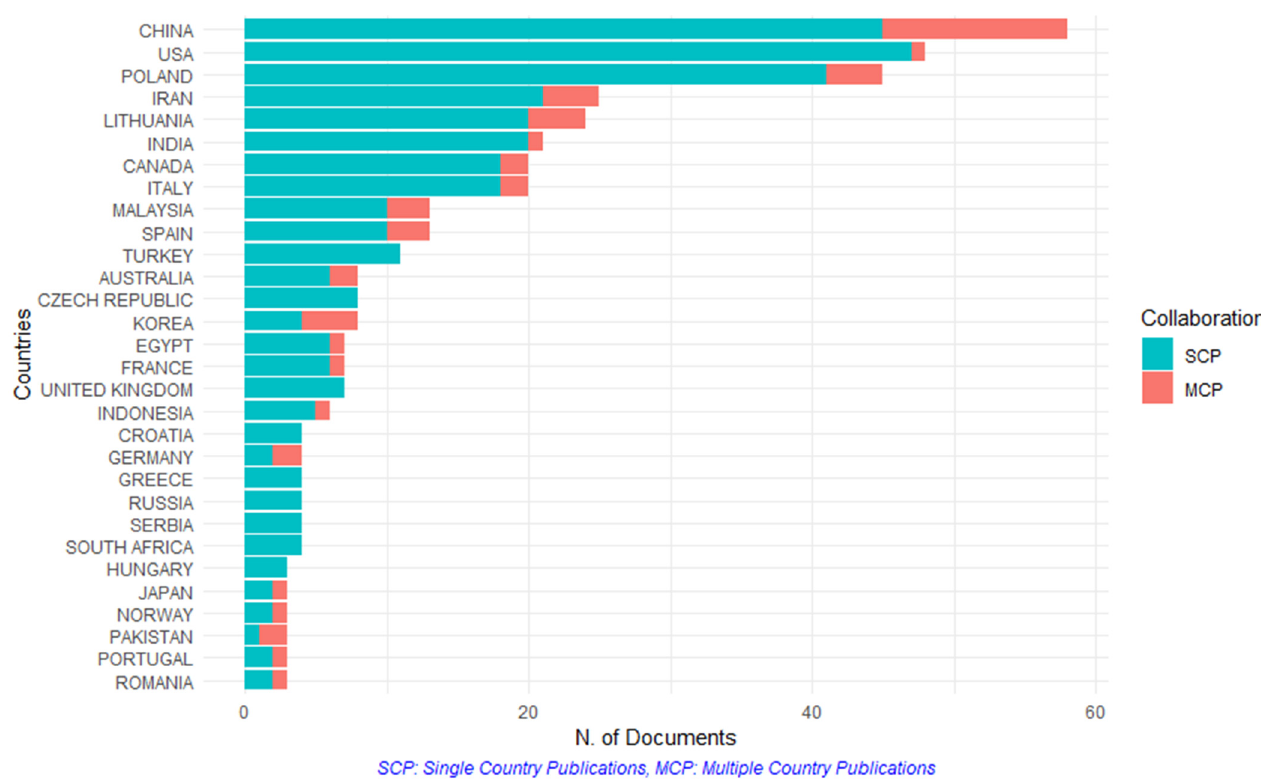
Figure 3. Most productive countries of corresponding authors (SCP ( green ) is the proportion of papers with all authors from the same country, while MCP ( red ) is the fraction of papers with authors from multiple countries).